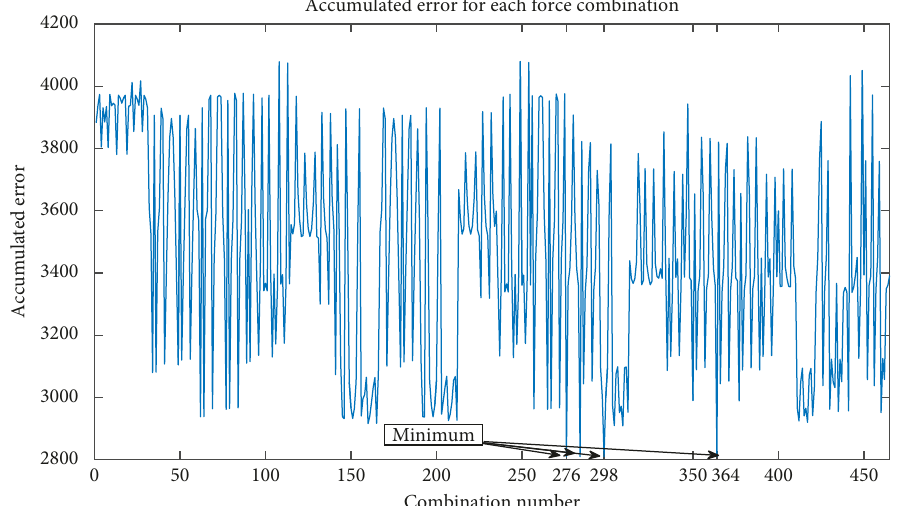
Figure 13: Accumulated error in frequency for the 3D cantilevered beam